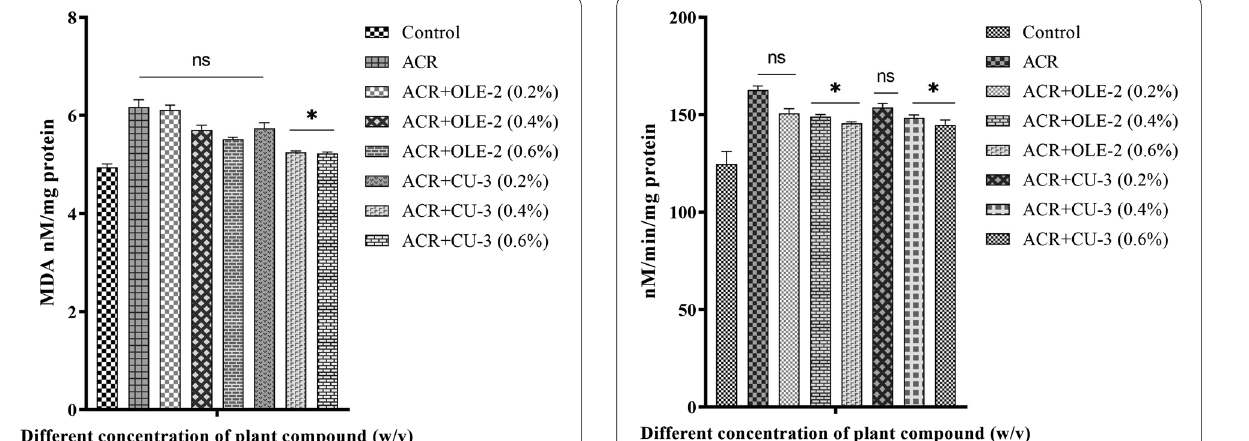
Fig. 7 Effect of plant fraction on LPO which is a oxidative stress marker in the ACR treated flies. The level of MDA was more in the ACR treated group. Plant fraction supplementation decreased the level of MDA in the treated flies’ group. Statistical significance was analysed by one-way ANOVA. Error bar represents the Mean The p value * p < 0.05 were considered as significant while comparing ACR treated group and co-exposed to ACR